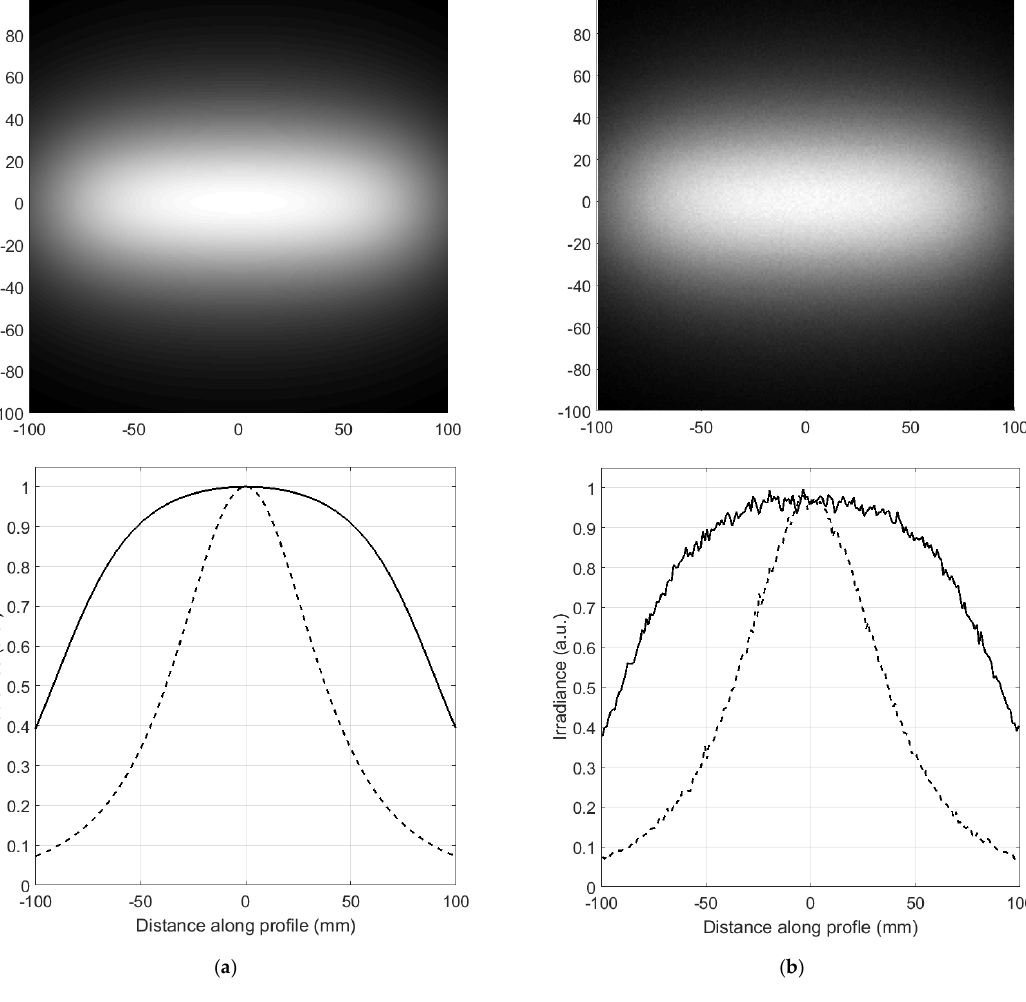
Figure 4. Irradiance map and central irradiance profile of rectangular source of 20 × 180 mm 2 ; detector of 200 × 200 mm 2 ; z detector 50 mm. (a)Flowline computation (b) Raytrace computation